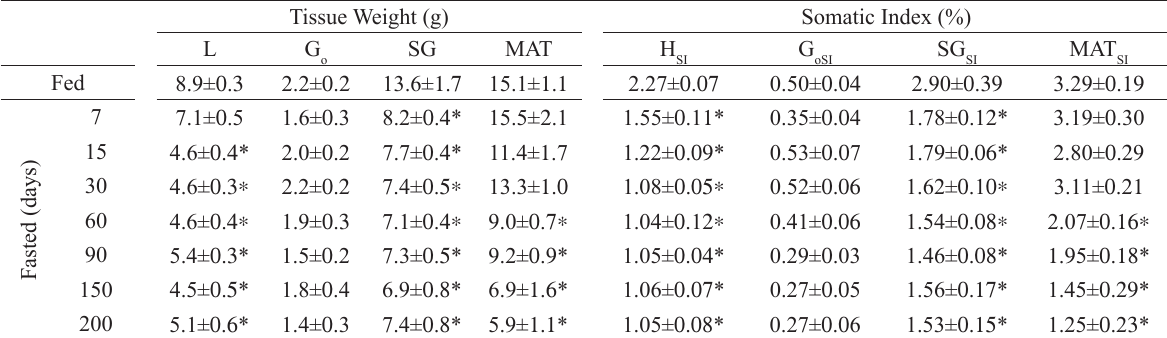
Tissue weight and their somatic index of fed and fasted red tilapias ( Oreochromis sp). Tissue Weight (g) Somatic Index (%)